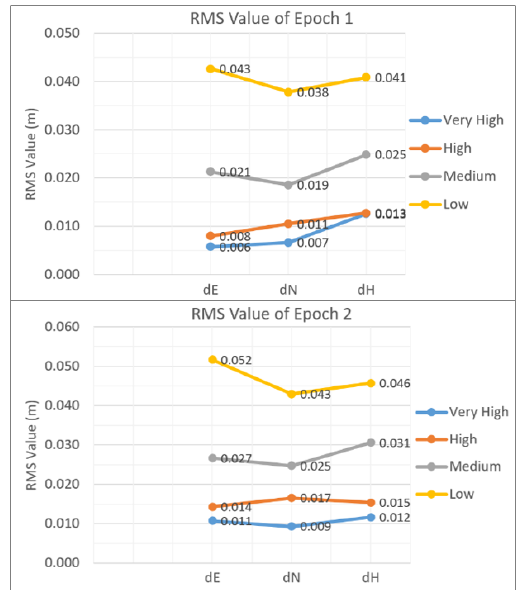
Figure 48. RMS values of coordinate differences between manually point picking and automatically computed by ScanMaster software (epoch 1 and